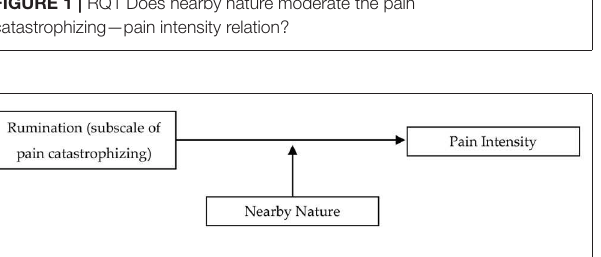
FIGURE 2 | RQ2 Does nearby nature moderate the relation between pain-related rumination (the most attention-based subscale of pain catastrophizing) and pain intensity?